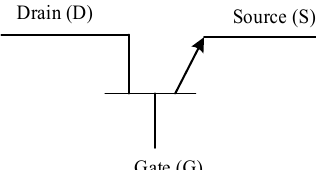
Figure 8. Schematic symbol of a static induction transistor [125].